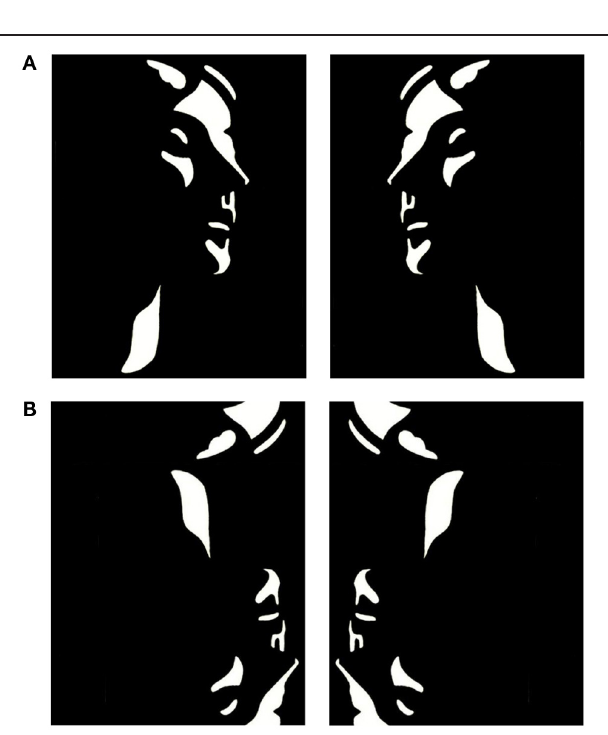
measured using coils placed at the subject’s nasion, and 1 cm ante- rior to the tragus of the left and right ear. Runs with a head movement exceeding 5 mm were